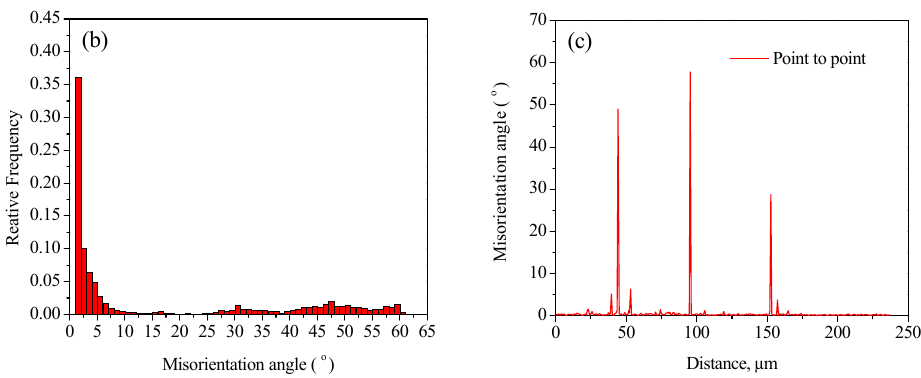
Figure 9. ( a ) Electron Backscattered Diffraction (EBSD) maps and ( b ) grain orientation profile of the TB8 titanium alloy with fine-grained sizes deformed at 900 °C, strain rate of 0.1 s − 1 , and true strain of 0.2. ( c ) Local misorientation profile of the TB8 titanium alloy with fine-grained sizes along the gray line marked in ( a ). The compression axis is vertical.